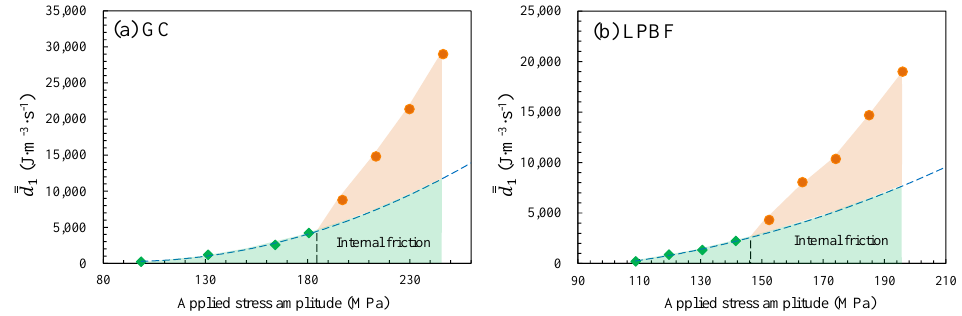
Figure 11. Separation of the energy dissipation rate induced by internal friction and irreversible degradation: ( a ) GC AlSi10Mg alloy; ( b ) LPBF AlSi10Mg